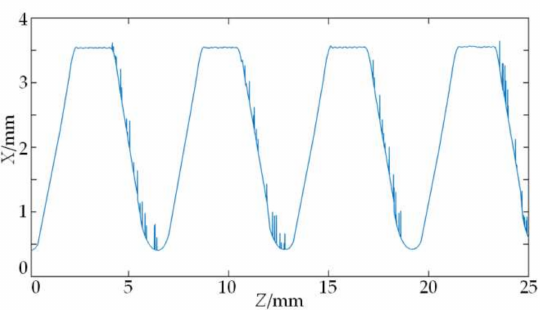
Figure 14. Original contour data of NC50 thread.